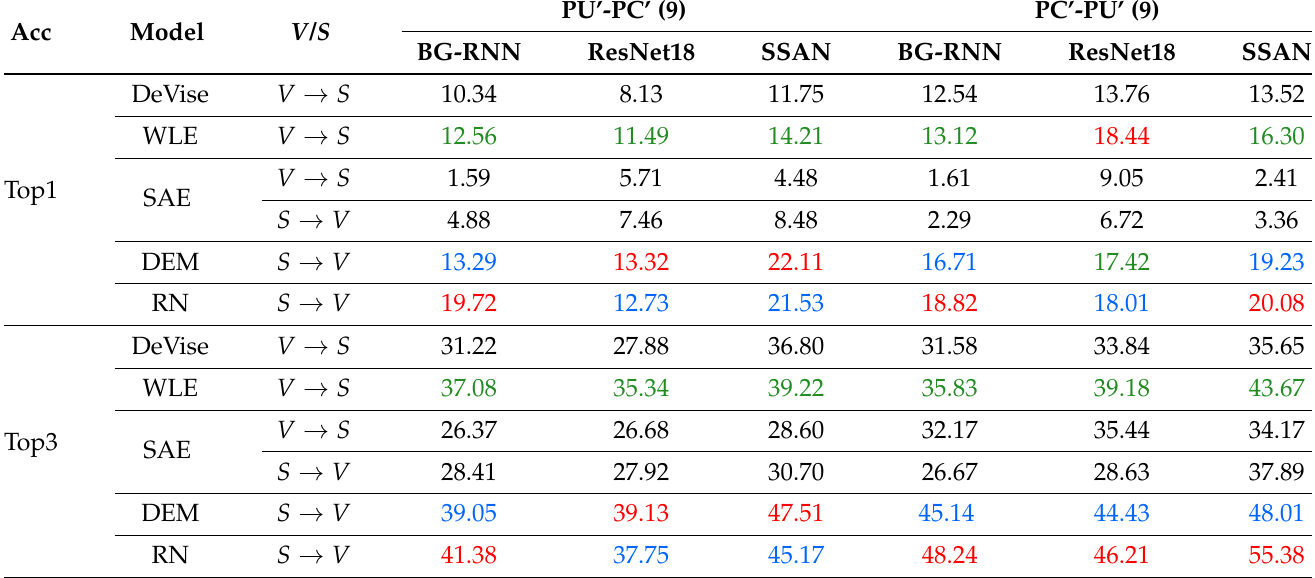
Table 7. Classification performance of multiple comparative methods on GroupB datasets (Case 5 and Case 6) under different visual feature extraction models including the bands-grouping RNN, ResNet18, and SSAN. The best results are shown in red, the blue results represent the second-ranked and the third-ranked results are displayed in